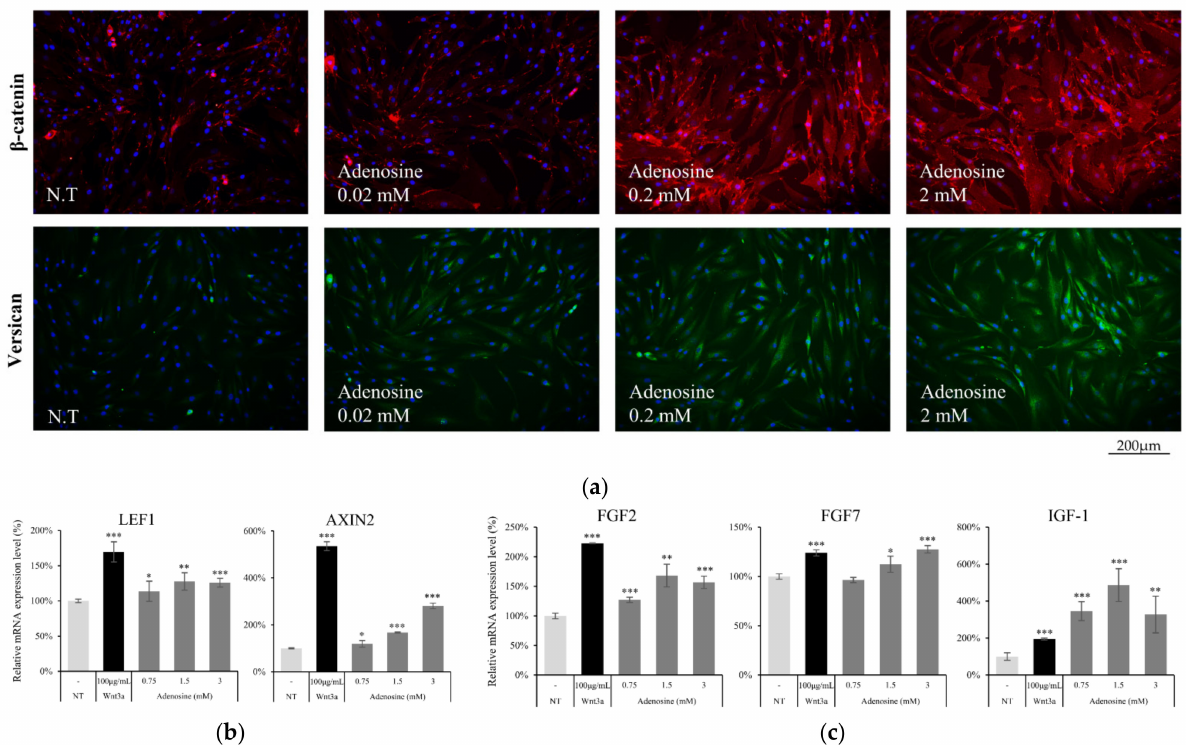
Figure 5. Adenosine activated Wnt target genes and growth factors in cultured human dermal papilla cells. ( a ) The induction of total β -catenin ( red ) and versican ( green ) expression level by 4 h treatment of adenosine was visualized by immunocytochemistry. Nuclei were stained by DAPI ( Blue ). The target genes of β -catenin were evaluated by RT-PCR after treatment with adenosine for 24 h. The mRNA expression level of ( b ) LEF1, AXIN2, and ( c ) growth factors (FGF2, FGF7, and IGF-1) and was increased by adenosine treatment. The data represent the means of five independent samples. NT, non-treated control; Significantly different compared with N.T (* p < 0.05, ** p < 0.01, *** p <